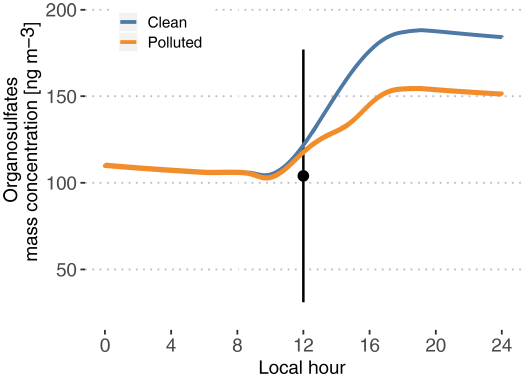
Figure 8. Modeled time evolution of particle-phase organosulfate mass concentration. Cases are identified as clean (blue) and polluted (orange). The point and vertical line depict the average and standard deviation of measurements reported in Glasius et al. (2018) for the wet season.